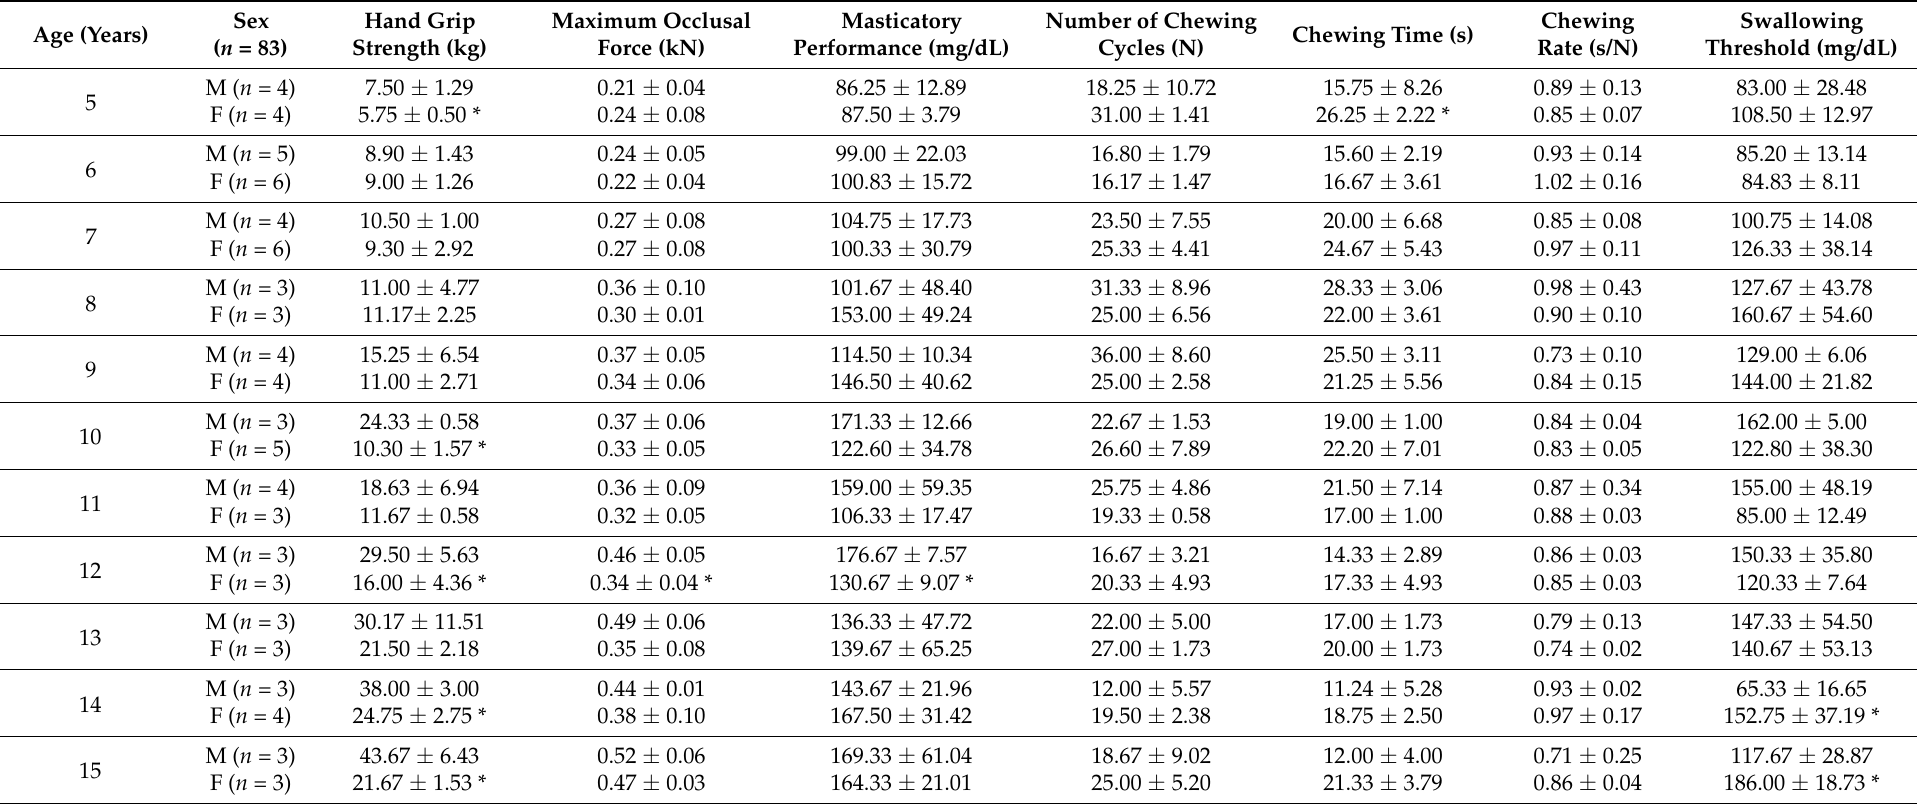
Table 2. Hand grip strength and oral functional parameters by age group and